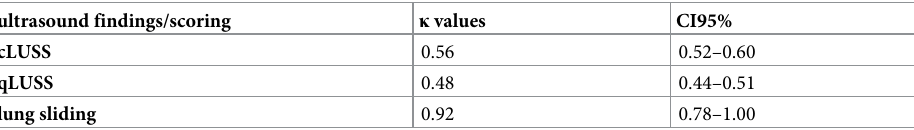
Table 4. Interobserver agreement of single loop